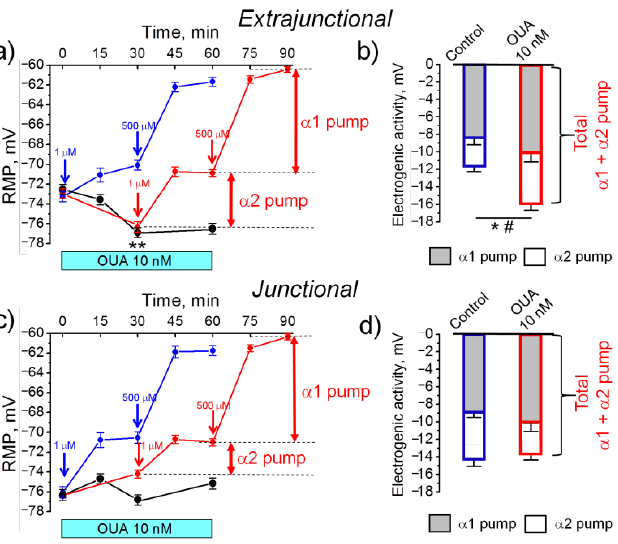
Figure 1. The effect of 10 nM ouabain on resting membrane potential (RMP) and electrogenic contribution of the α 1 and α 2 Na,K-ATPase in the sarcolemma of rat soleus muscles. The measurements were done in the ( a , b ) extrajunctional and ( c , d ) junctional regions of sarcolemma. ( a , c ) Black circles and lines show the RMP changes upon 10 nM ouabain incubation in bath solution at different time-points over 60 min experiment, as indicated. Red circles and lines show the RMP changes when bath ouabain concentration was increased from 10 nM to 1 µ M and 500 µ M (indicated by corresponding arrows) to estimate the electrogenic contribution of the α 1 and α 2 Na,K-ATPase (see also the Methods). Blue circles and lines demonstrate control measurements without pre-incubation with 10 nM ouabain, where the electrogenic contribution of the α 1 and α 2 Na,K-ATPase was estimated as above. ( b , d ) The estimated electrogenic contribution of the α 1 and α 2 Na,K-ATPase under control conditions and in the presence of 10 nM ouabain is shown in ( a ) and ( c ). Each data point is a mean value of membrane potentials measured in at least 100 fibers of 6–8 soleus muscles from 3–4 rats. One-way ANOVA. ( a ) ** p < 0.01—RMP compared to the corresponding initial value. ( b ) * p < 0.05—the α 2 Na,K-ATPase contribution and # p < 0.05—total α 1 and α 2 Na,K-ATPase contribution compared with the control